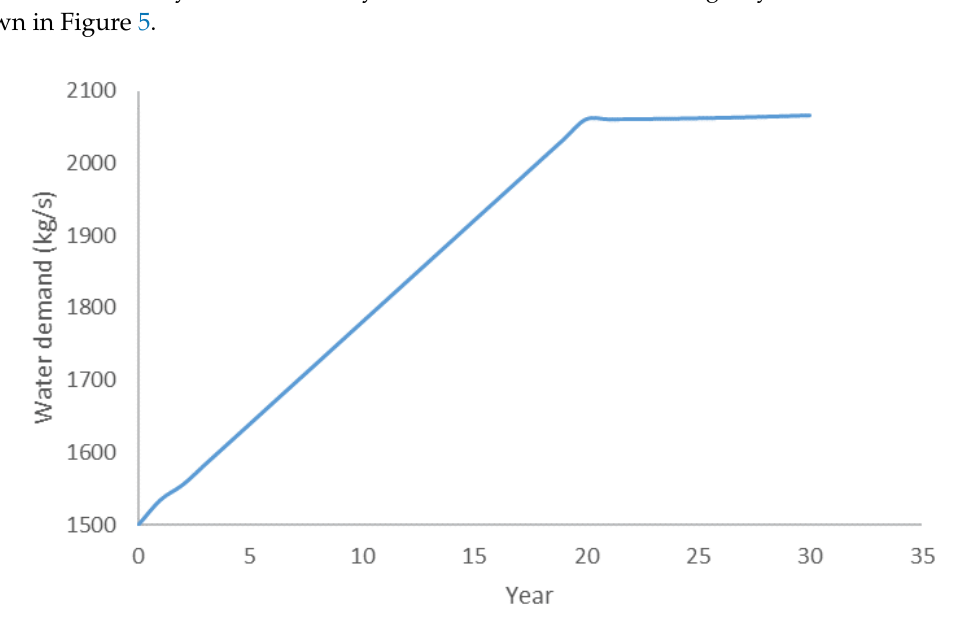
Figure 5. Water demand curve for the case study.